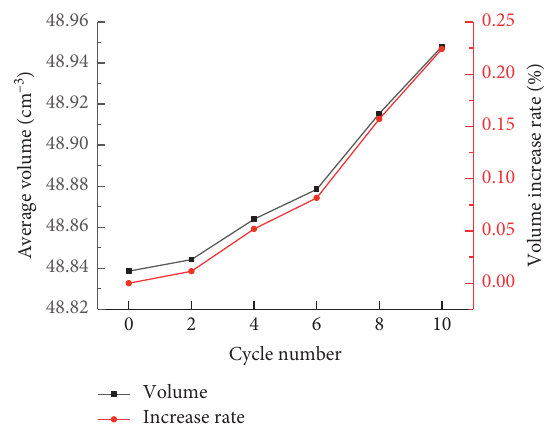
Figure 5: The relationship between specimen volume and the number of cycles at high temperature.